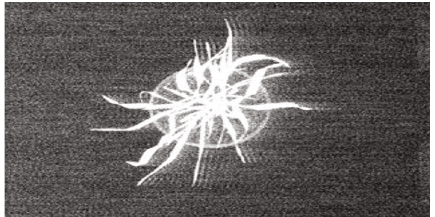
Figure 6: Segmentation algorithm used: K -means based on 4 mean values (Otsu); description: pixel membership loss is there but less than that of the static thresholding method.